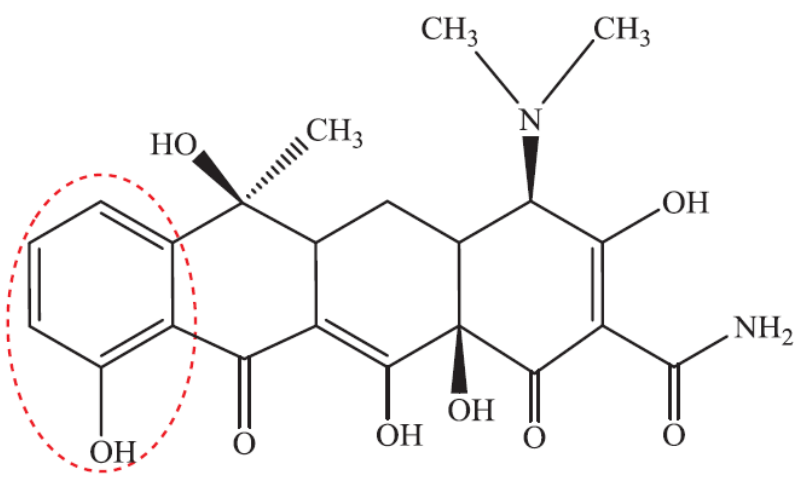
Figure 10. Tetracycline chemical structure.